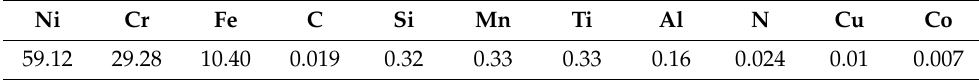
Table 1. Chemical composition of Alloy 690